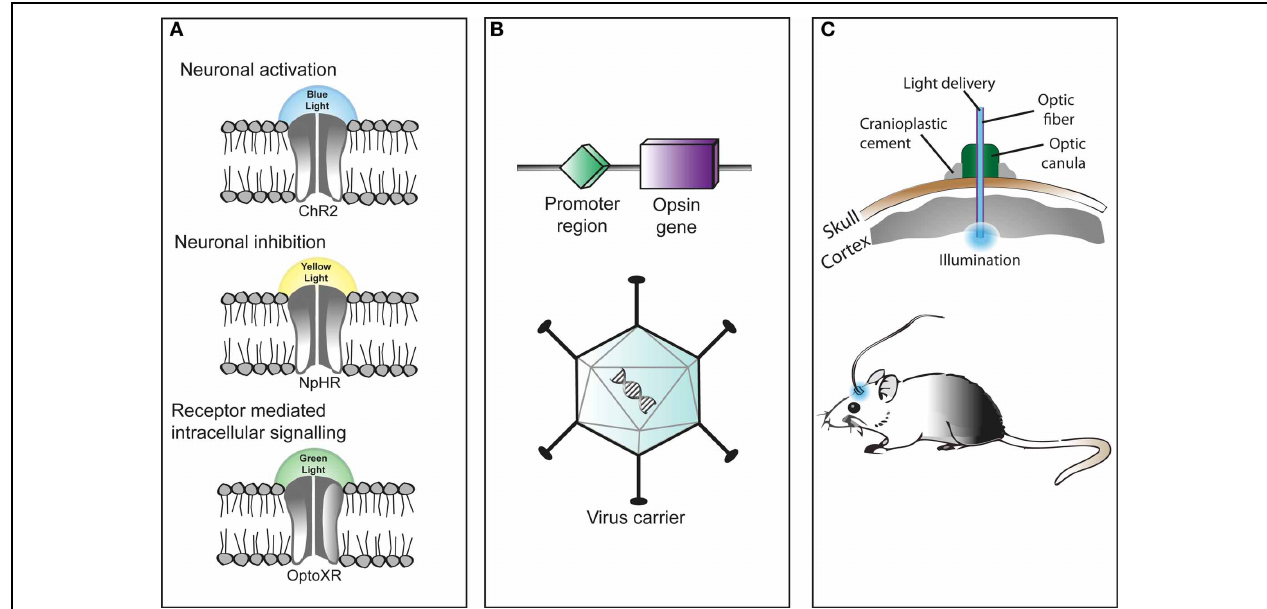
FIGURE 1 | Optogenetic stimulation consists of several steps. (A) First, light-responsive proteins called opsins need to be specified. There are two distinct superfamilies: microbical opsins (type I) and animal opsins (type II). Both types require retinal (a vitamin A-related organic cofactor) to convert light into energy, and the binding of retinal renders these opsins rhodopsins (Fenno et al., 2011). Several types of microbial opsins have been identified as suitable for optogenetic control and each type reacts differently to light stimulation of particular wavelengths; e.g., blue light makes channelrhodopsin-2 (ChR2) rapidly depolarize a neuron. The opsins used for optogenetics have different ion conductance regulation properties, acting within timeframes ranging from milliseconds to tens of minutes (Fenno et al., 2011). Examples include ChETAs (modified ChR2 opsins) that allow for ultrafast optogenetic control, and step-function opsins, purposely engineered to show prolonged activity after termination of the light stimulus (Fenno et al., 2011). As for neuronal inhibition, certain light-activated pumps may be used, such as the Natronomonas pharaonis Halorhodopsin (NpHR) ion pump. Here,